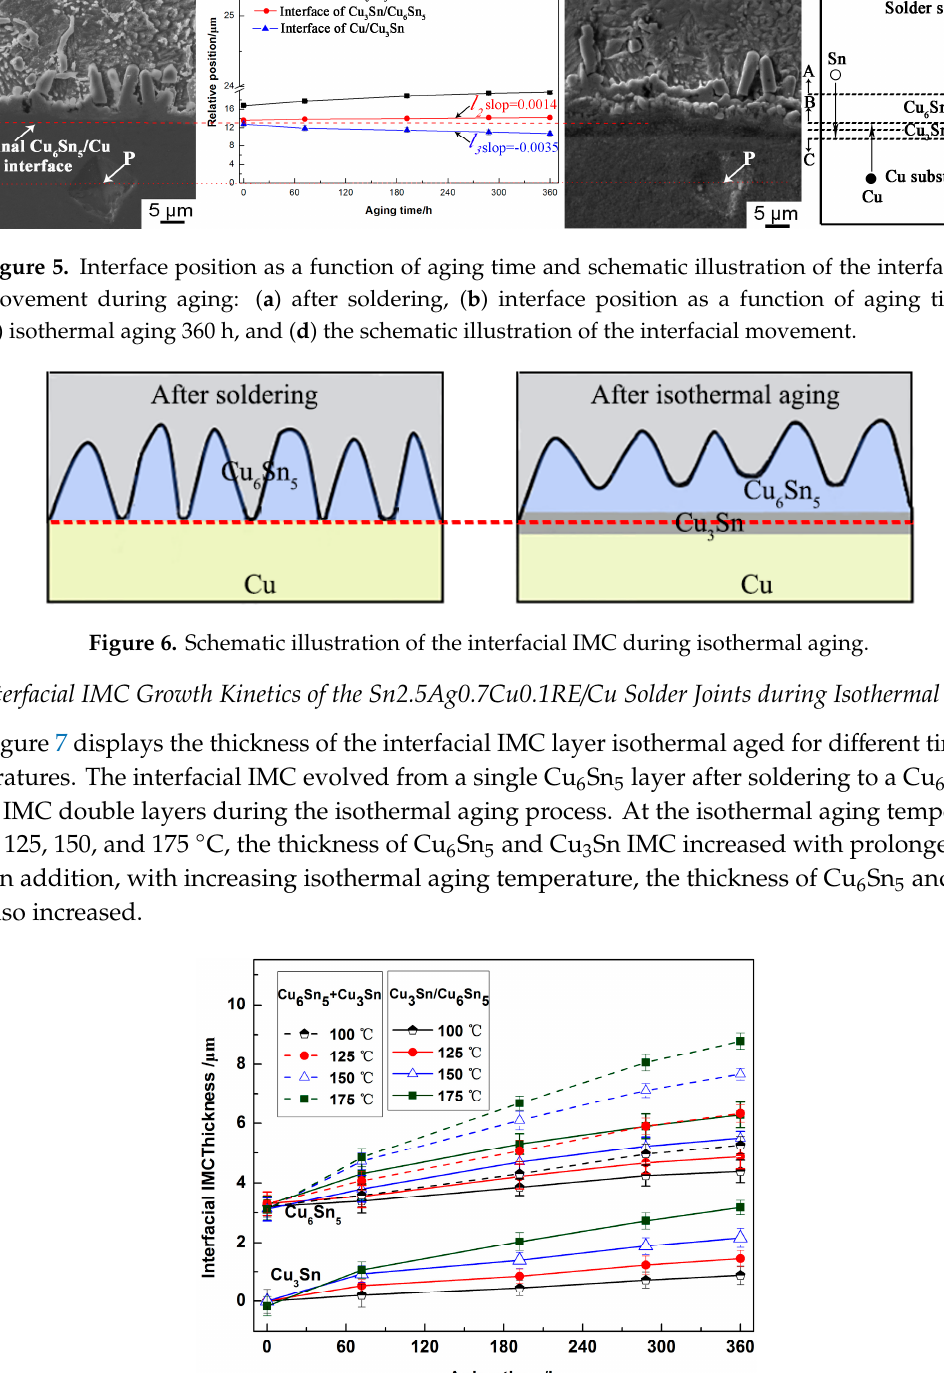
Figure 7. The thickness of interfacial IMC for different aging time and temperature.